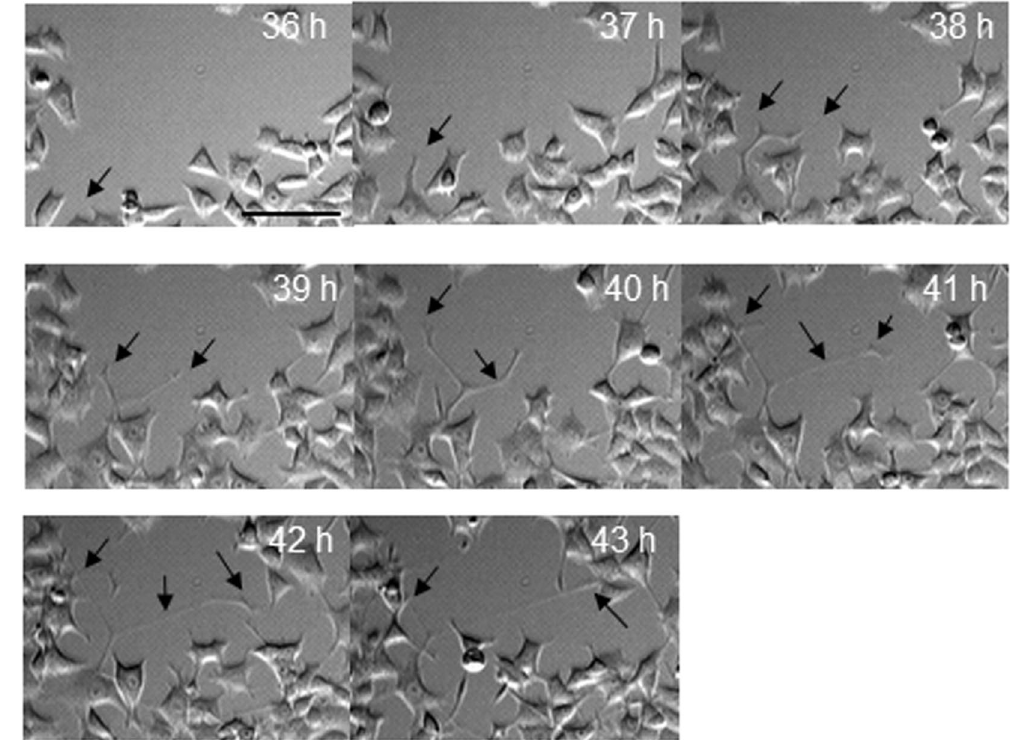
Figure 5. Monitoring of neurite elongation. Thin and detailed structures of elongating neurites from differentiated PC12 cells were visualized with eRC-CMS. Nerve growth factor was added to the culture medium at 24 hours of culture, and images were acquired from 36 hours to 43 hours of culture. Arrows indicate neurite- and neuronal growth cone-like structures from a single cell body. The scale bar is 50 μ